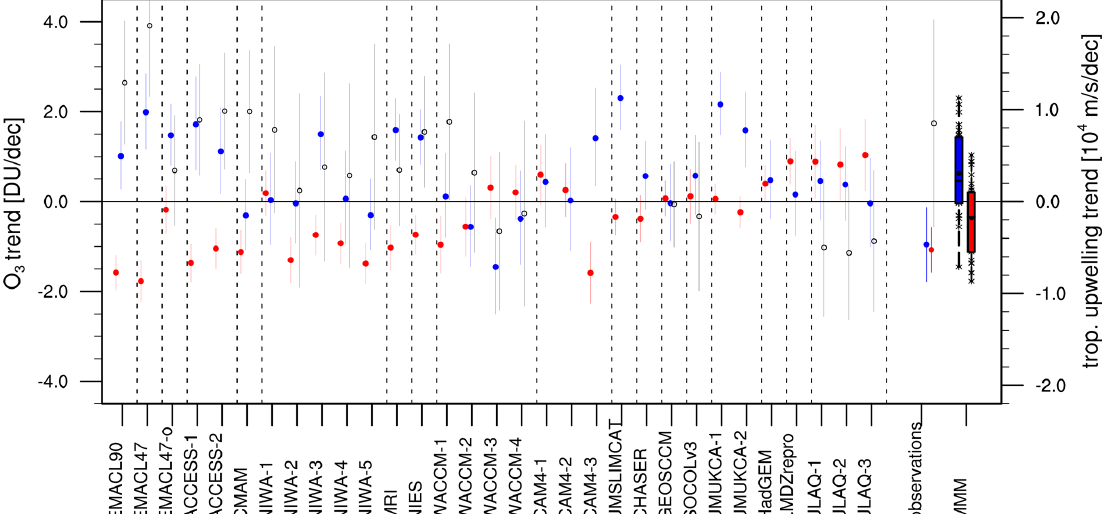
Figure 2. LS ozone trends and their uncertainties in the tropics (20 ◦ N–20 ◦ S; red dots) and northern mid-latitudes (30–50 ◦ N; blue dots) together with tropical upwelling trend (black circles; for all simulations providing TEM diagnostics) for the period 1998–2018 for all REF- C2 simulations. Dashed lines separate the individual models. Moreover, observational trends (1998–2018) and multi-model mean trends are given. Observational data for ozone are taken from BASIC SG and for tropical upwelling from ERA5 reanalysis. Error bars associated with each LS ozone trend represent the 90% confidence intervals. The multi-model mean trends are shown as boxplots: the solid black line in the box indicates the median, the black point indicates the MMM, and the coloured box ranges from the 25th to the 75th percentile of the trends. Crosses denote trends of individual model simulations not lying within the